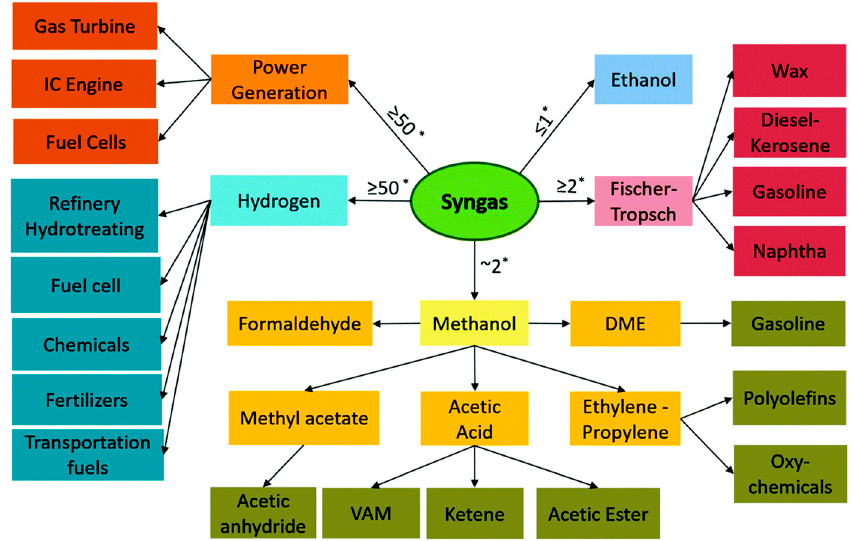
Figure 1. Application of syngas (* H 2 /CO ratio). Reprinted with permission from [1]. Copyright (2017) Royal Society of Chemistry (RSC), Cambridge, England.